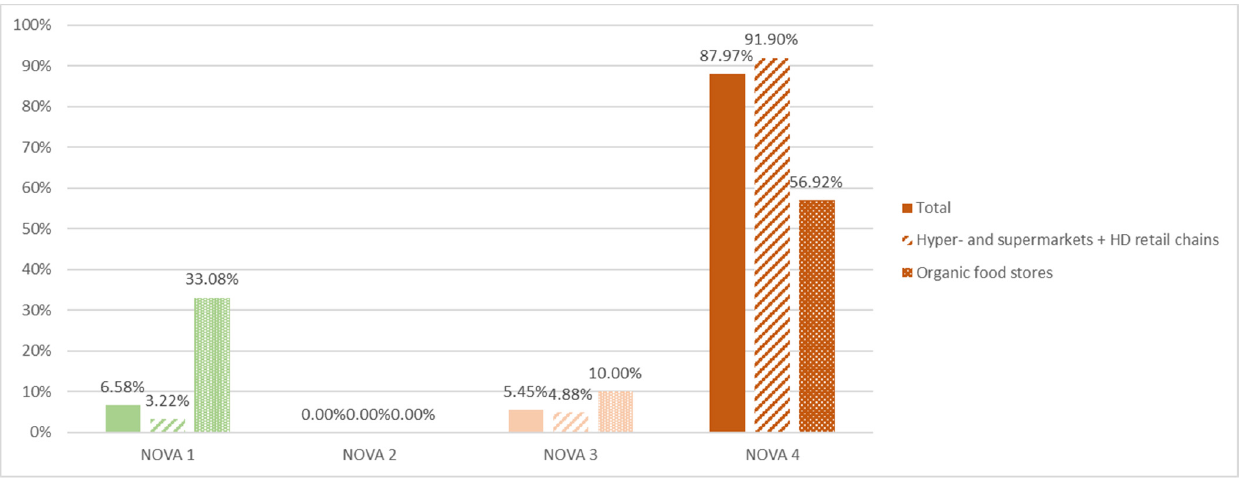
Figure 4. Distribution of NOVA groups for products included in the total sample ( n = 1155) and by store type.